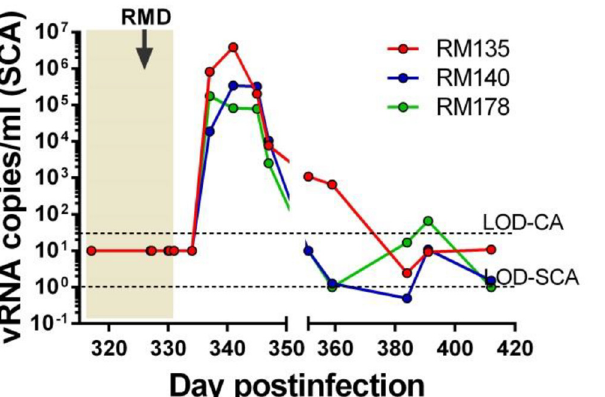
Fig 4. PVLs prior to and after RMD administration in RMs on antiretroviral therapy (ART) and virus rebound at the cessation of ART. Longitudinal PVLs were measured with a conventional assay (CA), with a limit of detection (LOD) of 30 viral RNA (vRNA) copies/ml of plasma (the top dashed line). PVLs were also measured with an ultrasensitive single copy assay (SCA), with a limit of detection of 1 vRNA copy/ml of plasma (bottom dashed line). During the follow-up, based on sample availability, the sensitivity of SCA ranged between 5 – 10 viral RNA copies/ml. Time of the RMD administration is illustrated with a black